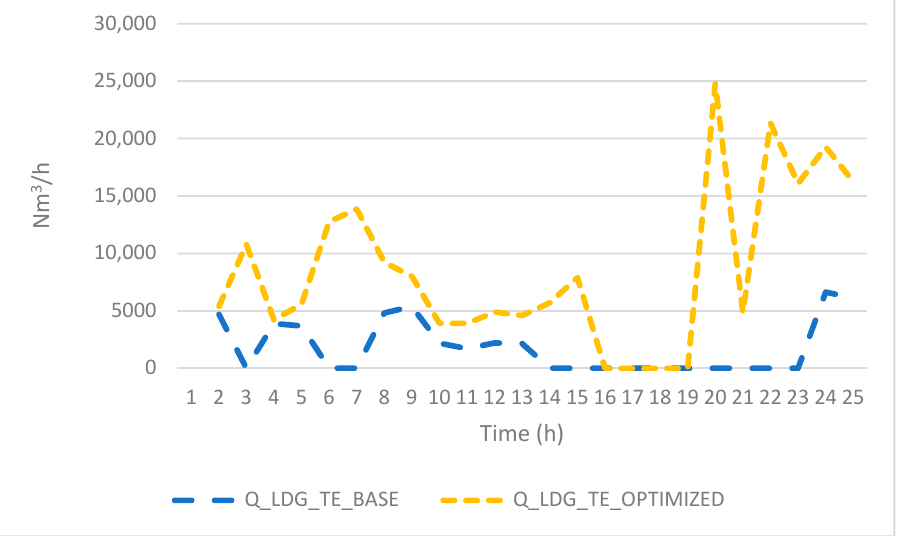
Figure 8. Base and optimized distribution LDG for steam production in the planning period.